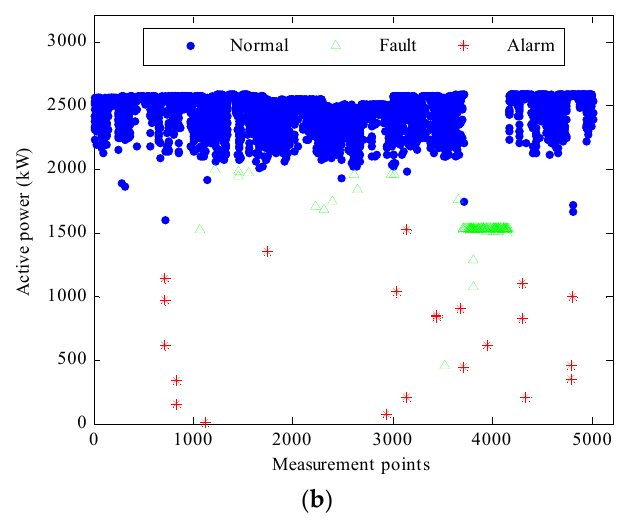
Figure 10. Active power output produced by PARAFAC model from samples using an optimised sensor array: ( a ) Using sensors 1, 2, 9, 12, 14, 26, 33, 52; ( b ) Using sensors 1, 8, 11, 13, 14, 19, 29, 48.